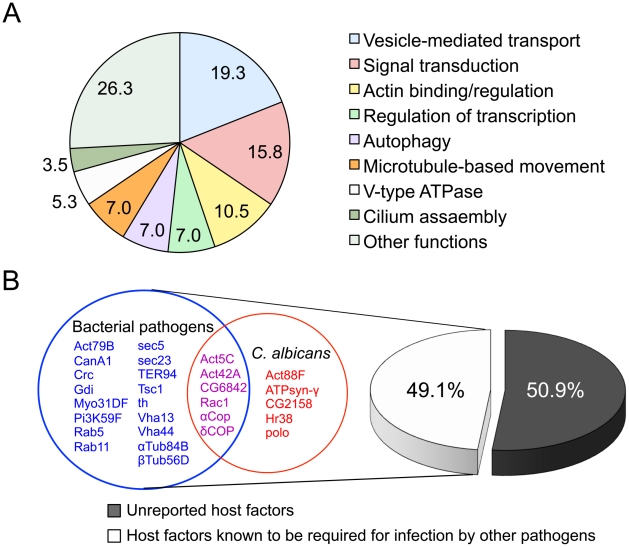
Identification of host factors regulating Cryptococcus neoformans infection.
A. Fifty-seven host factors that, when depleted, significantly altered Cn infection phenotypes were identified in an RNAi screen using Drosophila S2 host cells. The 57 host factors were analyzed using established gene ontology categories (http://flybase.org/). The results were plotted in a pie chart with the percentage of genes in each category indicated. B. Comparison of the 57 identified host factors with those that were reported to mediate bacterial or fungal pathogen infection of host cells. Among the 57 hits, twenty-nine (50.9%) had not been previously reported to function as host factors for intracellular fungal pathogens. Shared and unique host factors were determined by analyzing published data from screens performed in S2 cells infected with the following pathogens: Brucella melitensis
[41], Chlamydia caviae
[43], Chlamydia trachomatis
[44], Listeria monocytogenes
[38], [40], Mycobacterium fortuitum
[40], [42] and Candida albicans
[39]. The host factors that are shared with other human pathogens (49.1%) are listed in red (C. albicans), magenta (C. albicans and bacterial pathogens) and blue (bacterial pathogens). Each host factor mediates Cn phagocytosis and/or intracellular replication.